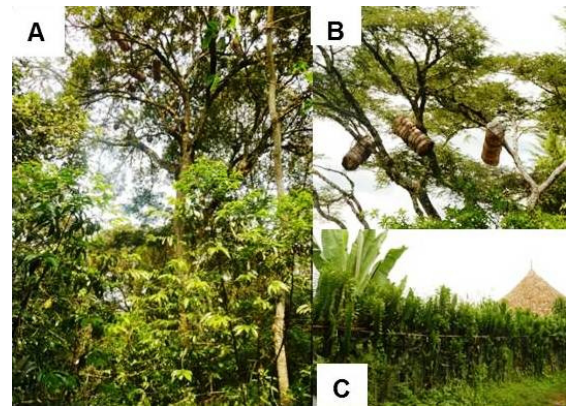
Fig. 6 . Semimanaged forest coffee (A), beehives hung on a tree (B), and live fence made from Euphorbia ampliphylla (C). Also note the beehives on a shade tree in